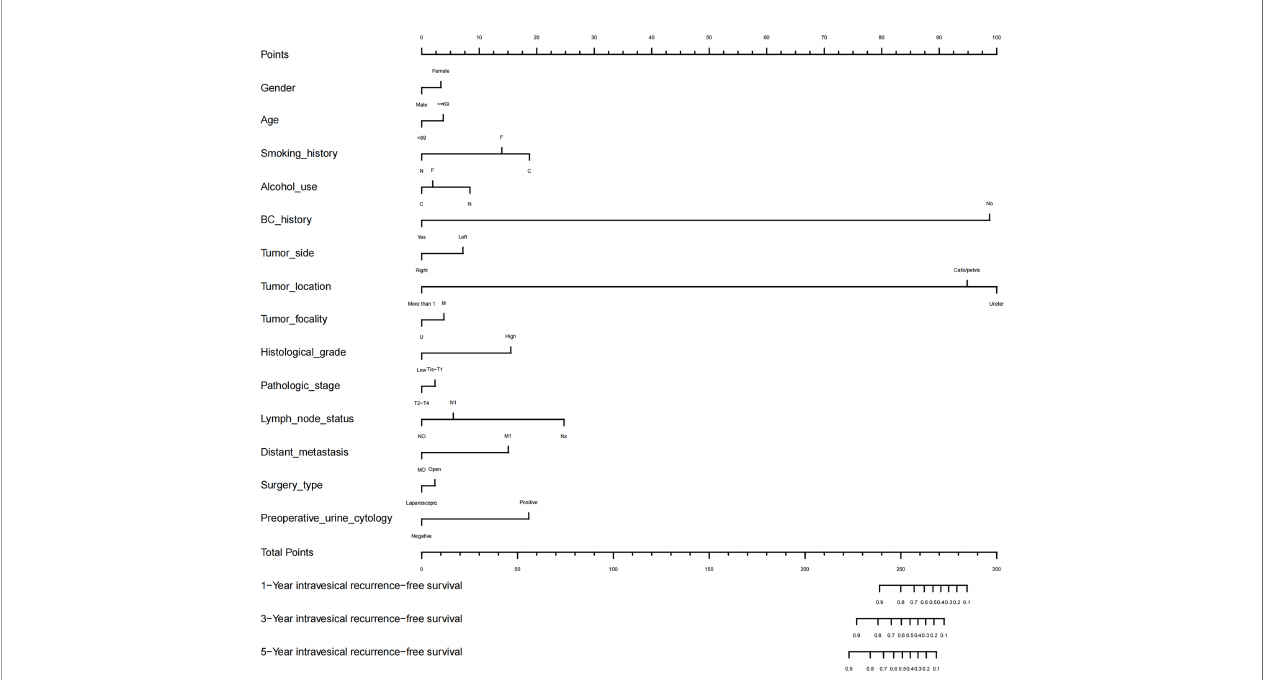
FIGURE 3 | Nomogram for 1-, 3-, and 5-year IV-RFS predictions of UUT-UC and associated predictive performance. The independent prognostic factors (including gender, age, smoking, alcohol use, history of bladder cancer, tumor side, tumor location, tumor focality, histological grade, pathologic stage, lymph node status, distant metastasis, and surgery type and preoperative urine cytology) were combined with the point designations to obtain the total prognostic score. “ N ” represented non-smoker/drinker, “ C ” represented current smoker/drinker, “ F ” represented former smoker/drinker, “ U ” represented unifocal tumor, “ M ” represented multifocal tumor, and “ BC ” represented bladder